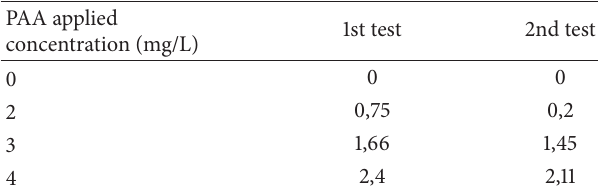
Table 5: PAA residual in mg/L for both tests with